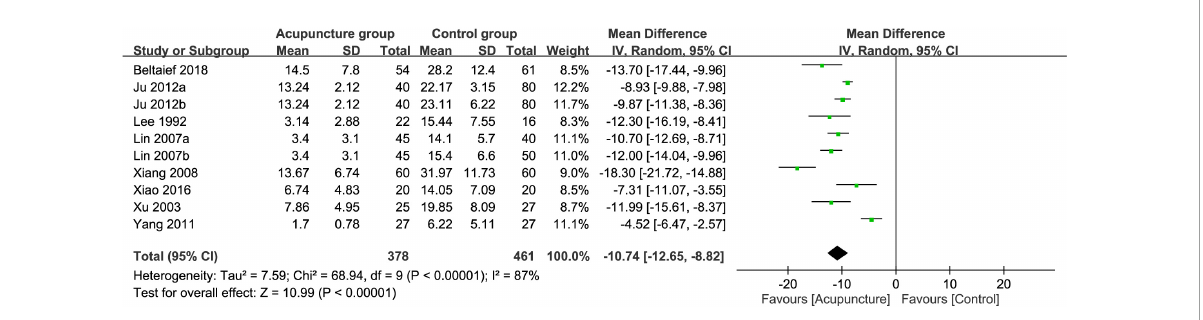
FIGURE7 Forest plot comparing the time to pain relief between acupuncture and control groups. CI, confidence interval; IV, inverse variance.